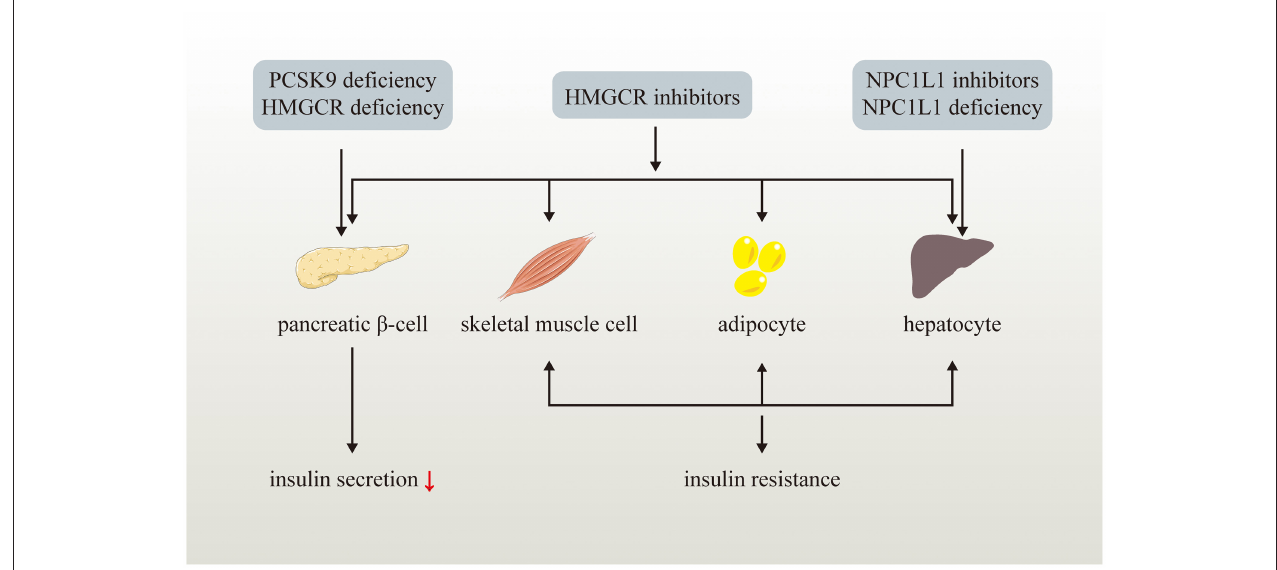
FIGURE 2 | Effects of LDL-C lowering drugs or genetic variants on glucose metabolism. LDL-C lowering drugs or genetic variants disturb glucose homeostasis via multiple ways. Genetic PCSK9 deficiency impairs pancreatic β -cell insulin secretion while NPC1L1 inhibitors and genetic NPC1L1 deficiency lead to insulin resistance of hepatocyte. HMGCR inhibitors and genetic HMGCR deficiency impairs pancreatic β -cell insulin secretion and induce insulin resistance of skeletal muscle cell, adipocyte, and